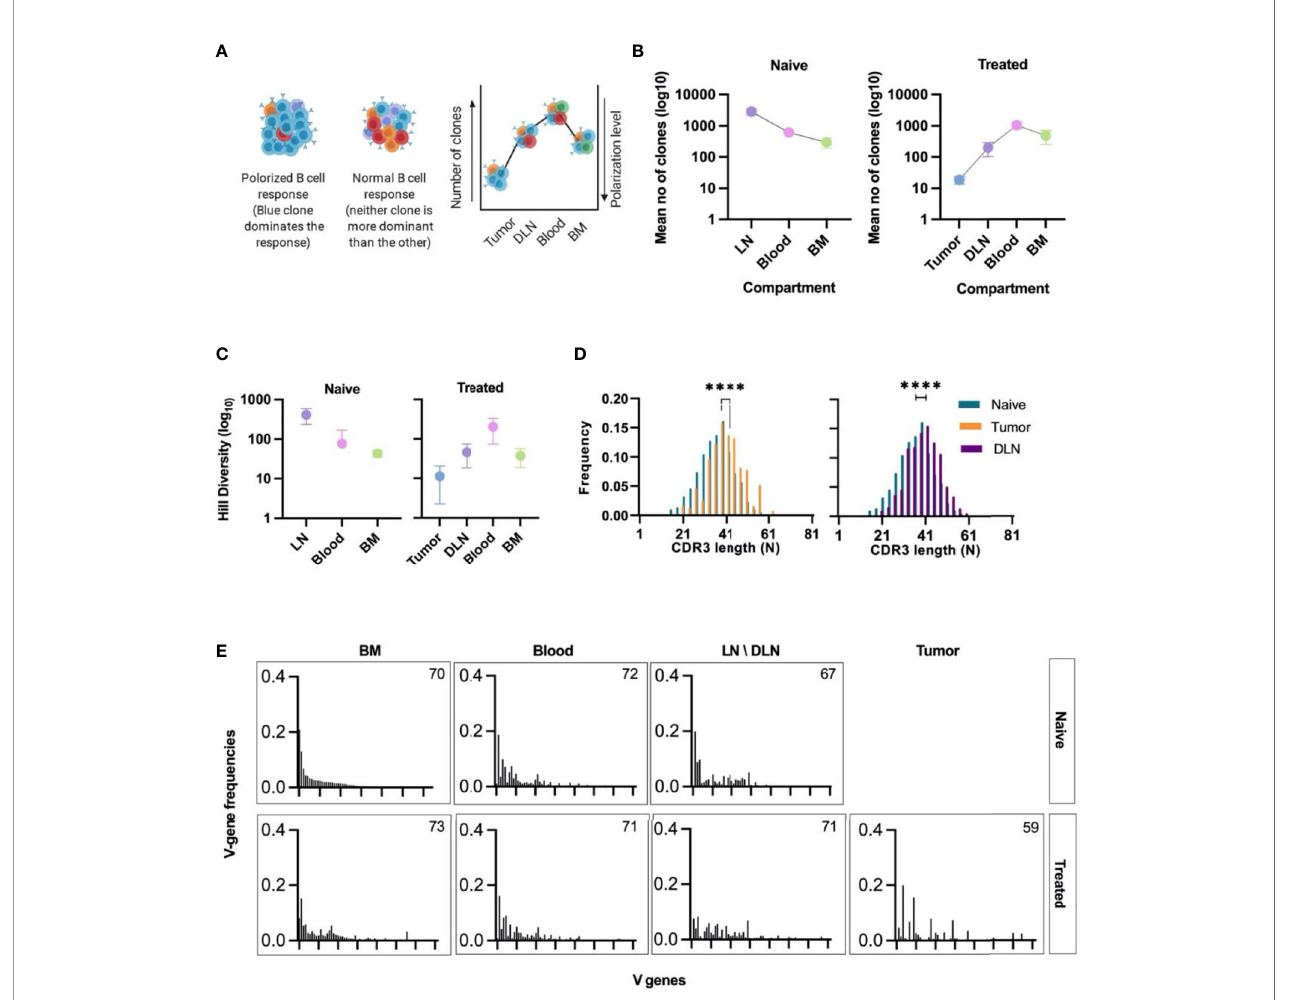
FIGURE 3 | Clonal analysis, CDRH3 length distribution, and V gene usage of B cells isolated from different tissues. (A) Schematic representation of clonal polarization. Each color represents a single clone. As the number of clones increases, the polarization decreases. (B) Polarization curve; the mean number of clones (log 10 ) that contribute to 80% of all V H sequences reads in each tissue is shown on the y-axis. The lower the value, the higher the polarization level of the B cell response. Error bars represent the standard error of the mean (SEM). (C) Hill diversity (log 10 ) – used as a measure of clonal diversity – was calculated for all clones in each tissue. Error bars represent standard deviation. (D) CDRH3 length distribution of intra-tumoral and DLN unqiue V H seqeunces. The median CDRH3 length of clones from the tumor or the DLNs of treated mice (orange/purple bars) was compared to that of naïve clones (red bars). Statistical signi fi cance was determined by using an nonparametric, unpaired, two-sided, Mann-Whitney t-test. For both the DLNs and the tumor, the p-value <0.05 was considered statistically signi fi cant, ****p ≤ 0.0001. (E) Bar plots of V gene usage frequency in each tissue. All V genes were sorted according to the frequency of V genes observed in the naïve B cells subset (IgM + B cells from the bone narrow of naïve mice). Number of V genes used in each tissue is detailed on the bar plot. Naïve - naïve mice, Treated - tumor- bearing